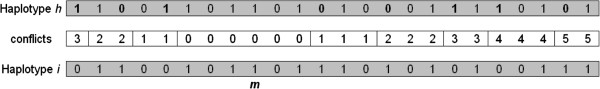
Illustration of the definition ofch,imkfor imputation of maternally inherited alleles. Haplotype i is the maternal haplotype of the individual; haplotype h is one of the haplotypes from the haplotype library that is to be scored; for a specified value of k (k = 0, 1, 2, 3, 4), the number ch,imk of markers for which there were exactly k haplotype conflicts in the interval between the respective marker allele and marker m was calculated; with respect to marker m, the number of markers with k = 0 conflict is ch,im0=6; for k = 1, 2, 3, 4, the numbers of markers with k conflicts are ch,im1=5, ch,im2=5, ch,im3=3, and ch,im4=3, respectively.